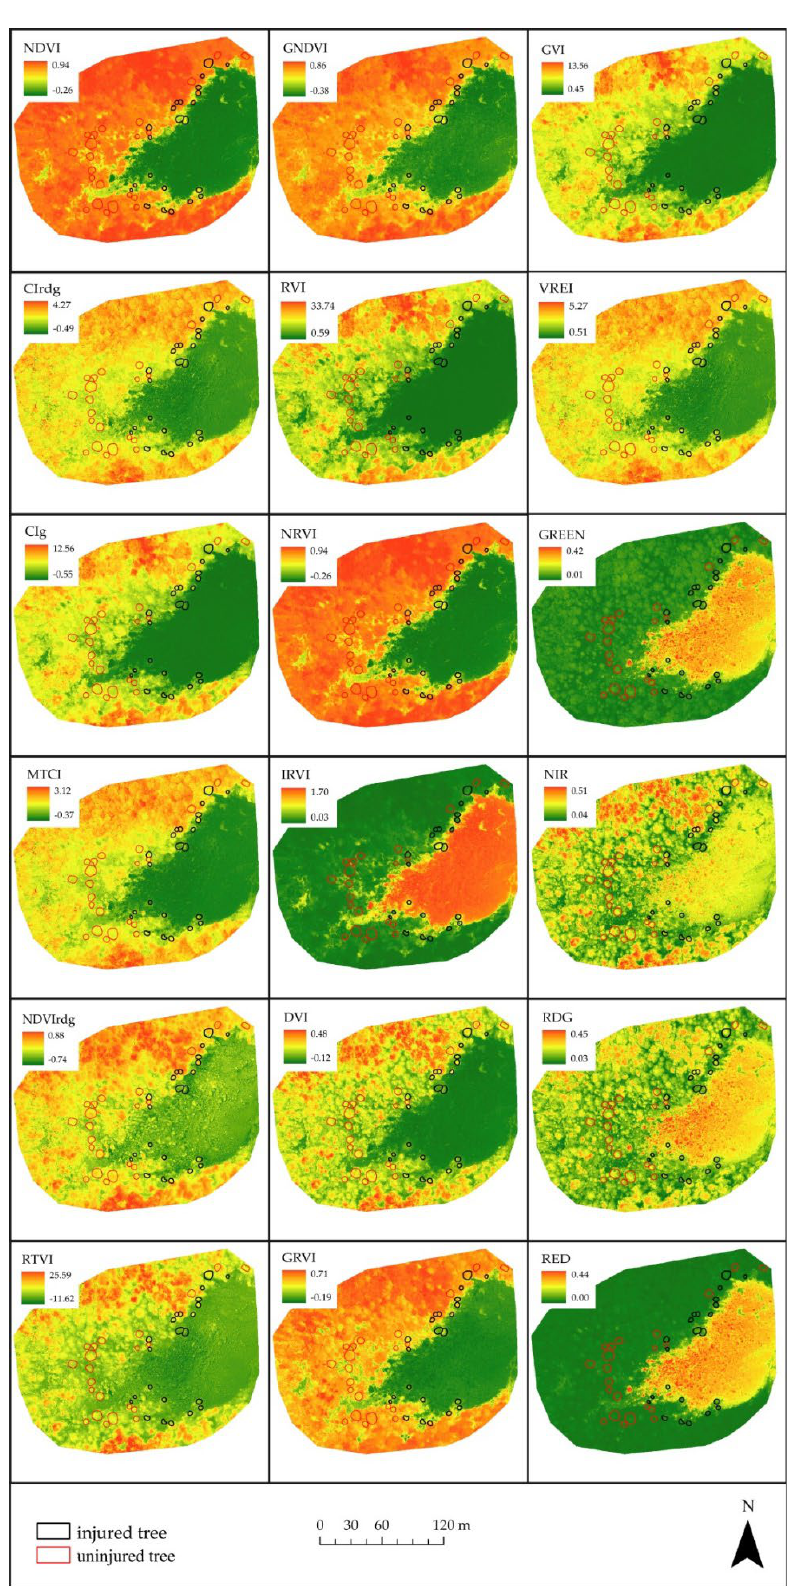
Figure A2. The maps of all vegetation indices (VIs) and individual spectral bands for the Cerkev site (4 July 2018).